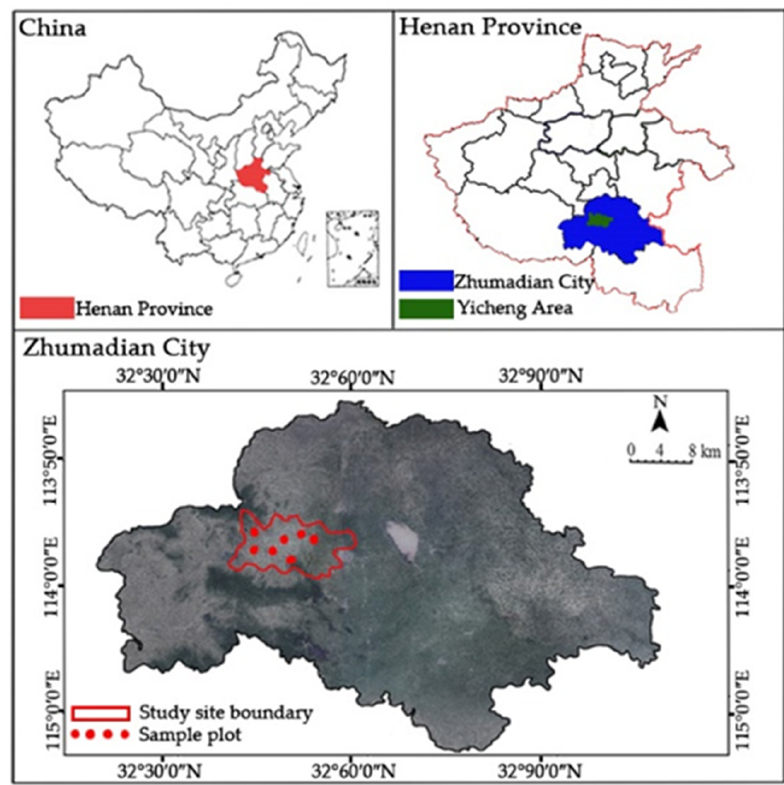
Figure 1. Location analysis.